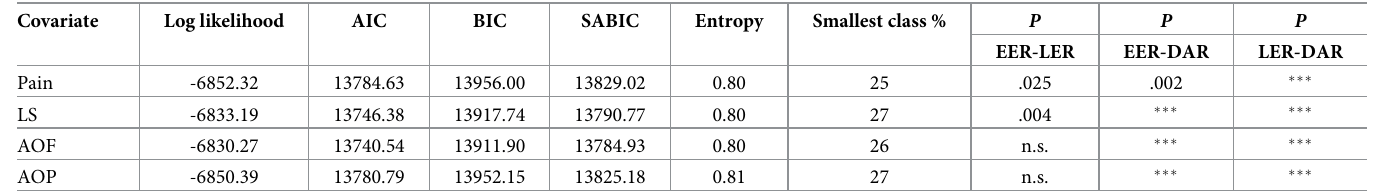
EER-DAR LER-DAR